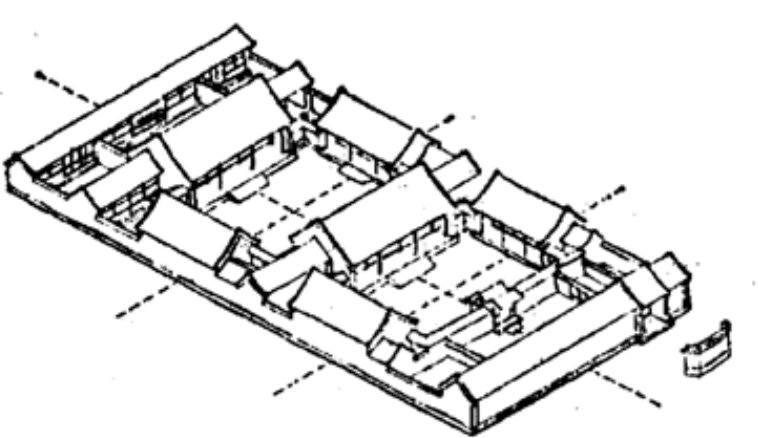
Figure 16. Siheyuan Perspective [15].